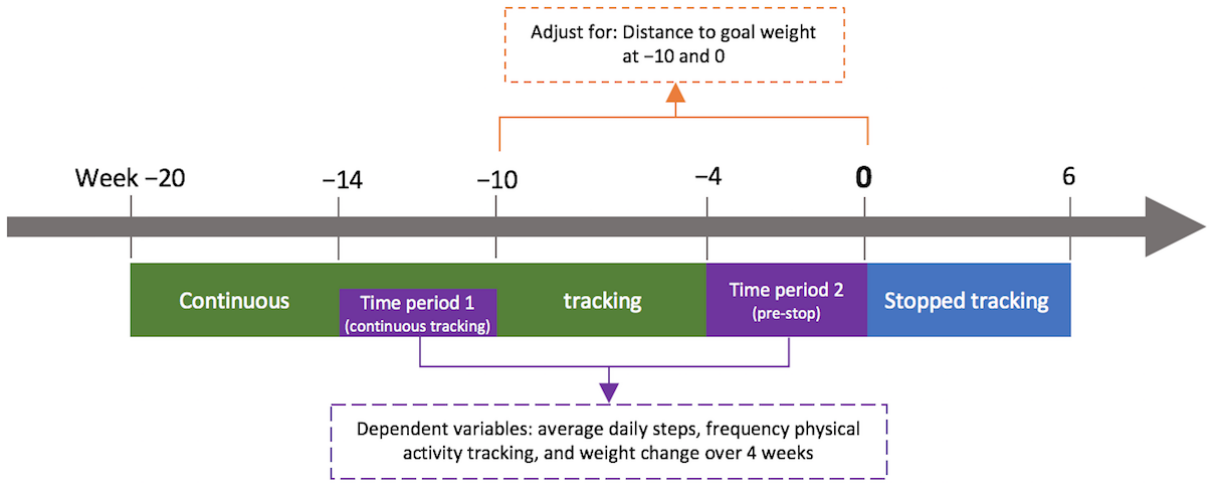
Figure 1. Case-crossover study design to establish linear mixed effects models for research question 1.